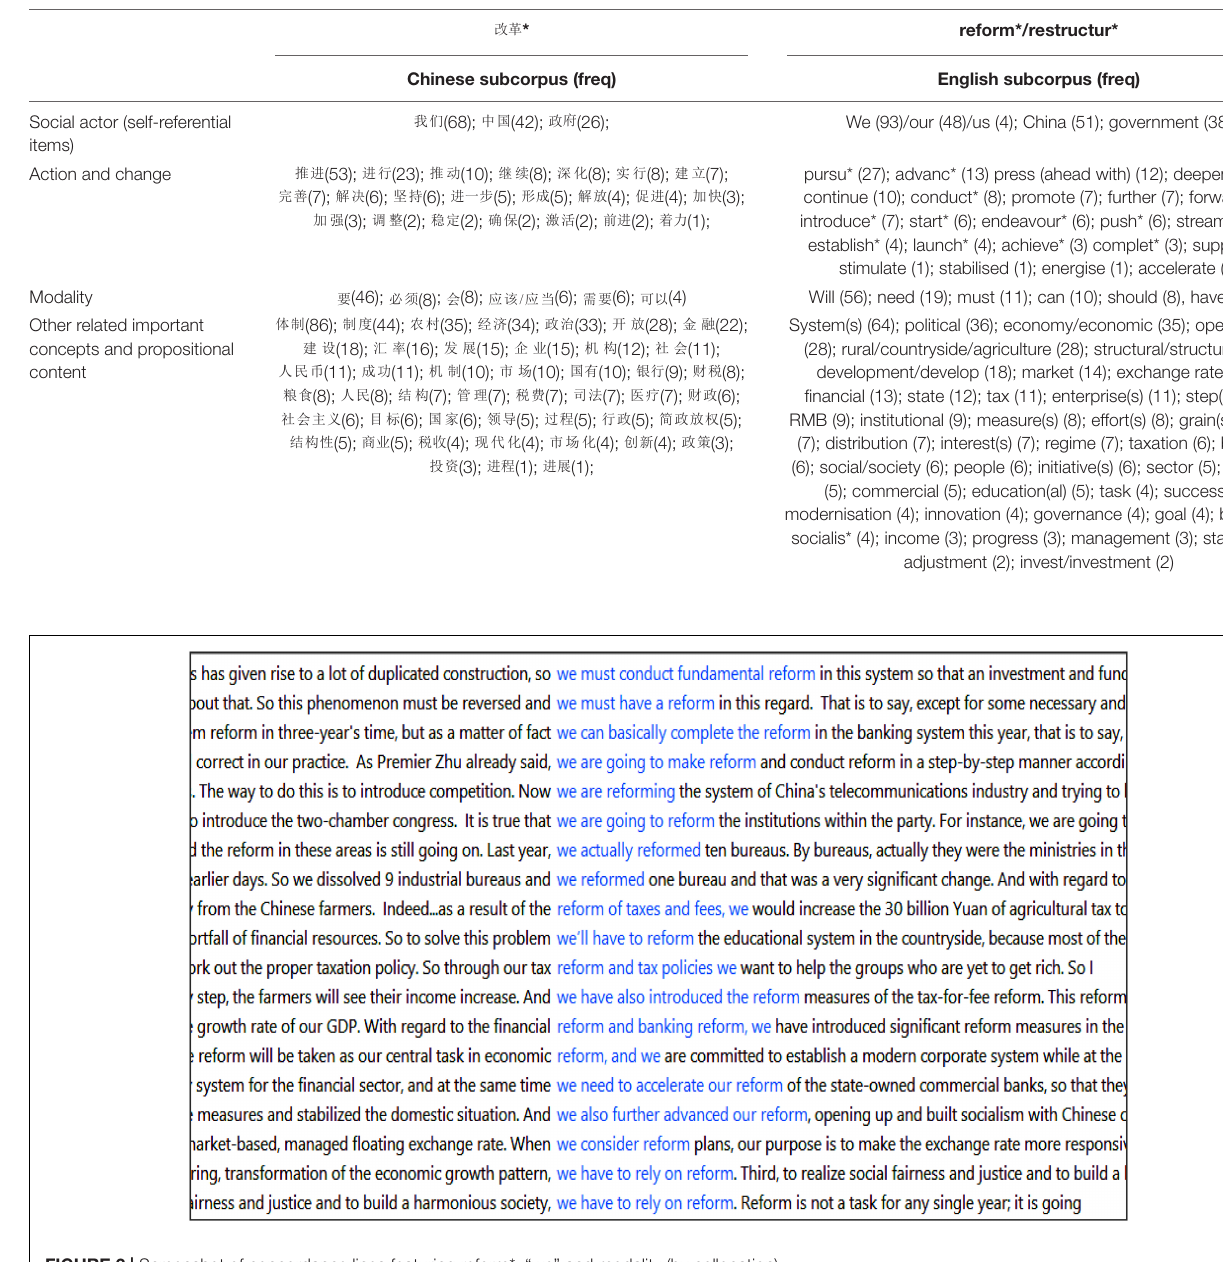
FIGURE 2 | Screenshot of concordance lines featuring reform*, “we” and modality (by